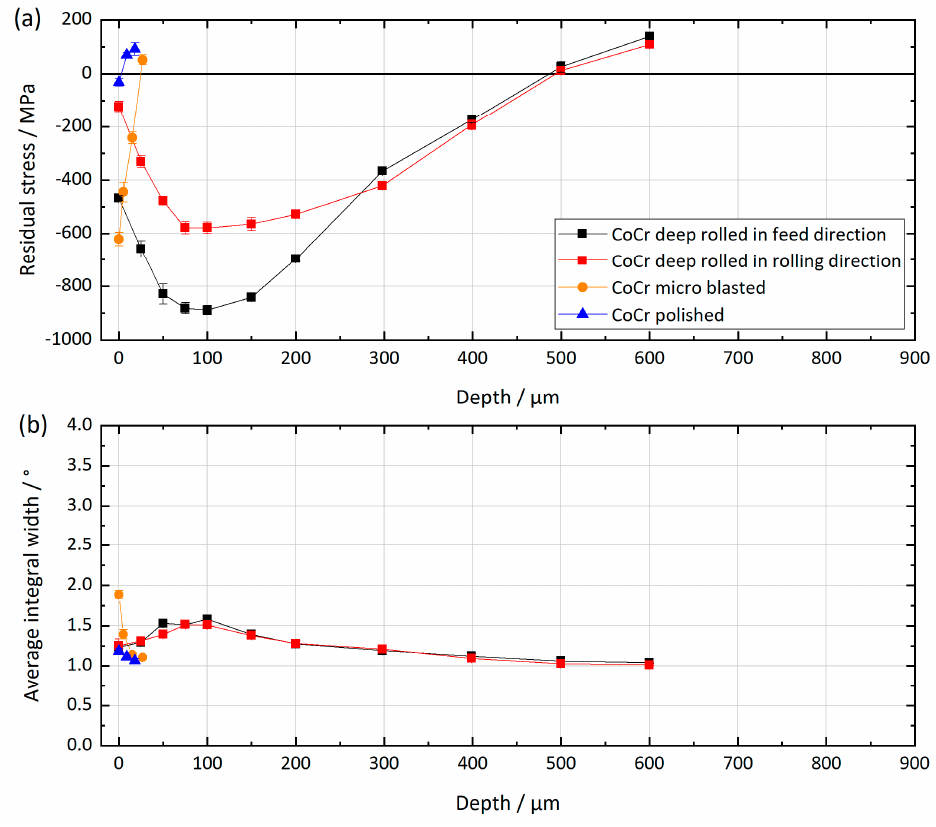
Figure 4. Residual stress depth distributions (a) and depths distributions of the average integral widths of the diffraction lines (b) for the three differently surface-treated CoCrMo (CoCr) samples.